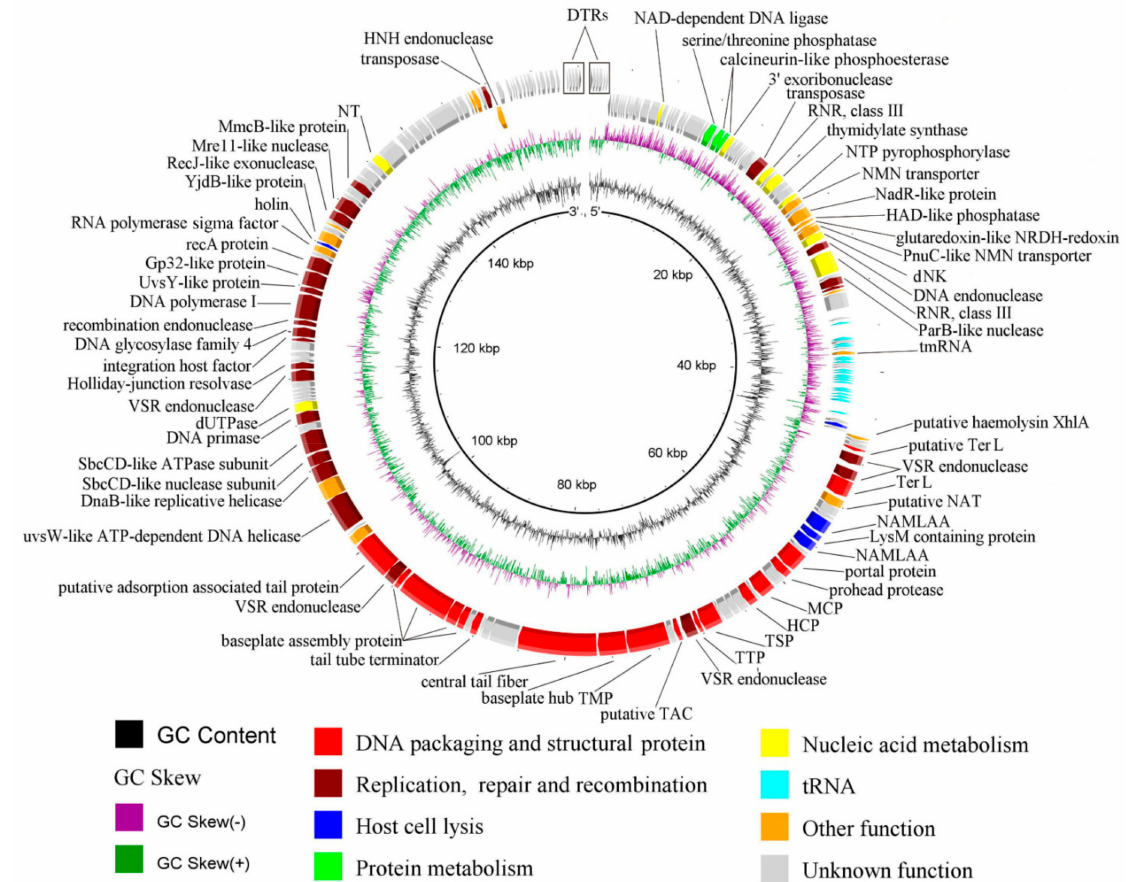
Figure 5. The Enterococcus phage iF6 chromosome map. Functionally assigned ORFs are highlighted according to their general functions (see the color scheme at the bottom). Abbreviations: